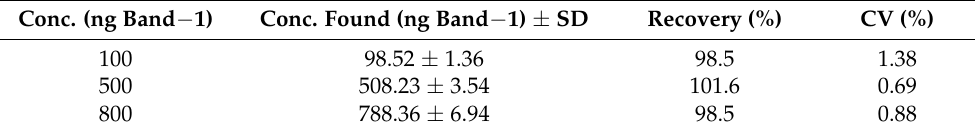
Table 3. Accuracy assessment findings of caffeine for the green HPTLC method (mean ± SD; n = 6).